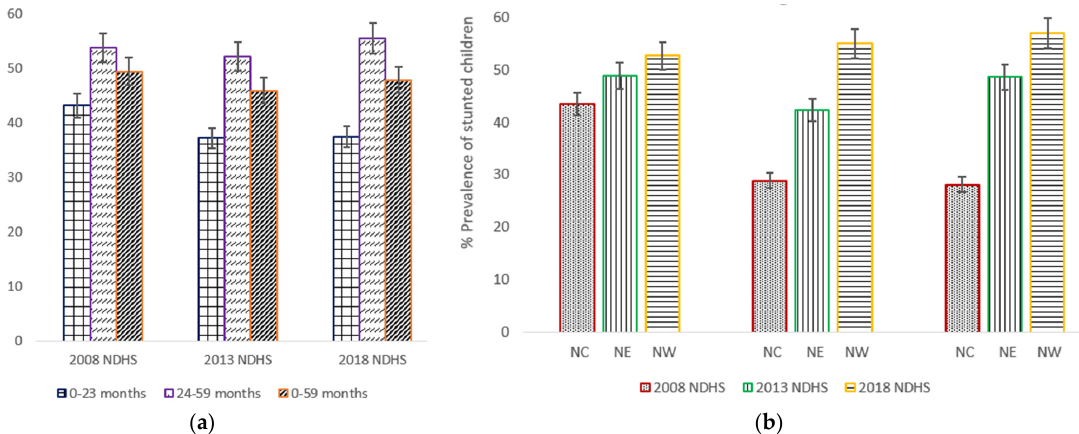
Figure 2. ( a ) Trends in prevalence of stunted children aged 0–23 months, 24–59 months, and 0–59 months, with 95% confidence interval by year of the northern geopolitical zones (NGZs) of Nigeria Demographic and Health Surveys (NDHS), 2008–2018; ( b ) Trends in prevalence of stunted children aged between 0 and 59 months by the Northern geopolitical zones (north central (NC), northeast (NE) and northwest (NW)). Notes: If 95% confidence interval (CI) bars do not overlap, it implies that the difference is statistically significant ( p –value < 0.05).